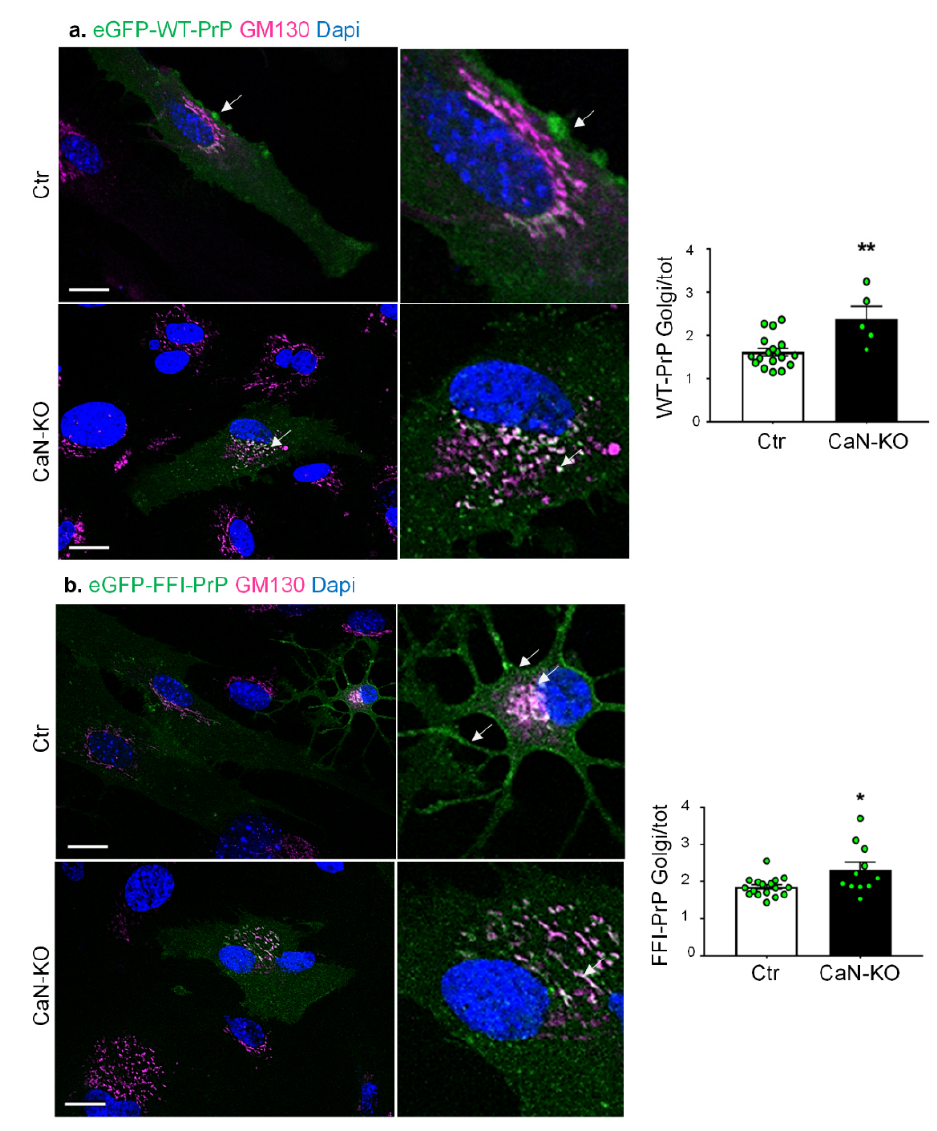
Figure 7. Analysis of WT and D177N PrP transient expression in Ctr and CaN-KO astrocytes. Ctr and CaN-KO astrocytes were transfected with eGFP-WT PrP ( a ) and eGFP-D177N PrP ( b ) fusion proteins (green), immunostained with an anti-GM130 (pink) to mark the Golgi apparatus and reacted with DAPI to stain the nuclei (blue). Images were acquired with a confocal microscope, scale bar 20 µ m. PrP fluorescent density in the Golgi apparatus is expressed as mean ± SEM, from four independent coverslips, * p < 0.05 and ** p <